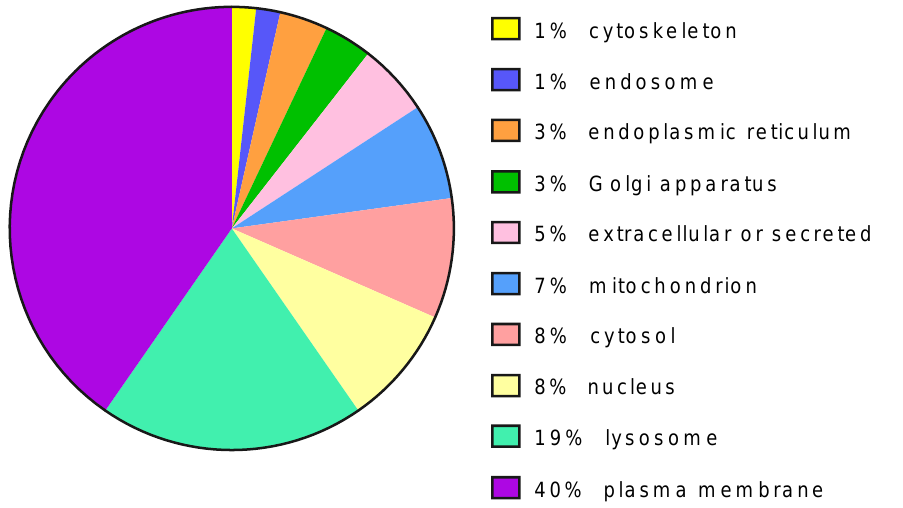
Figure 4. Distribution of protein targets of pharmacological chaperones per cell localization.